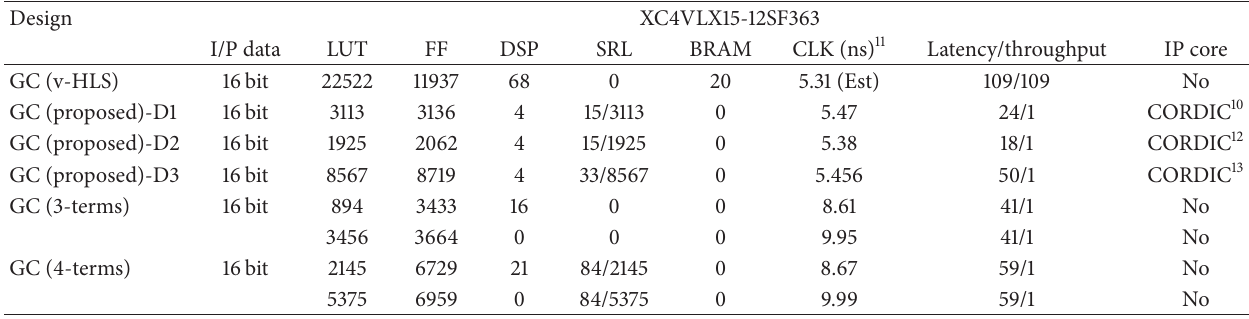
Table 10: Mapping of greater circle distance formula.